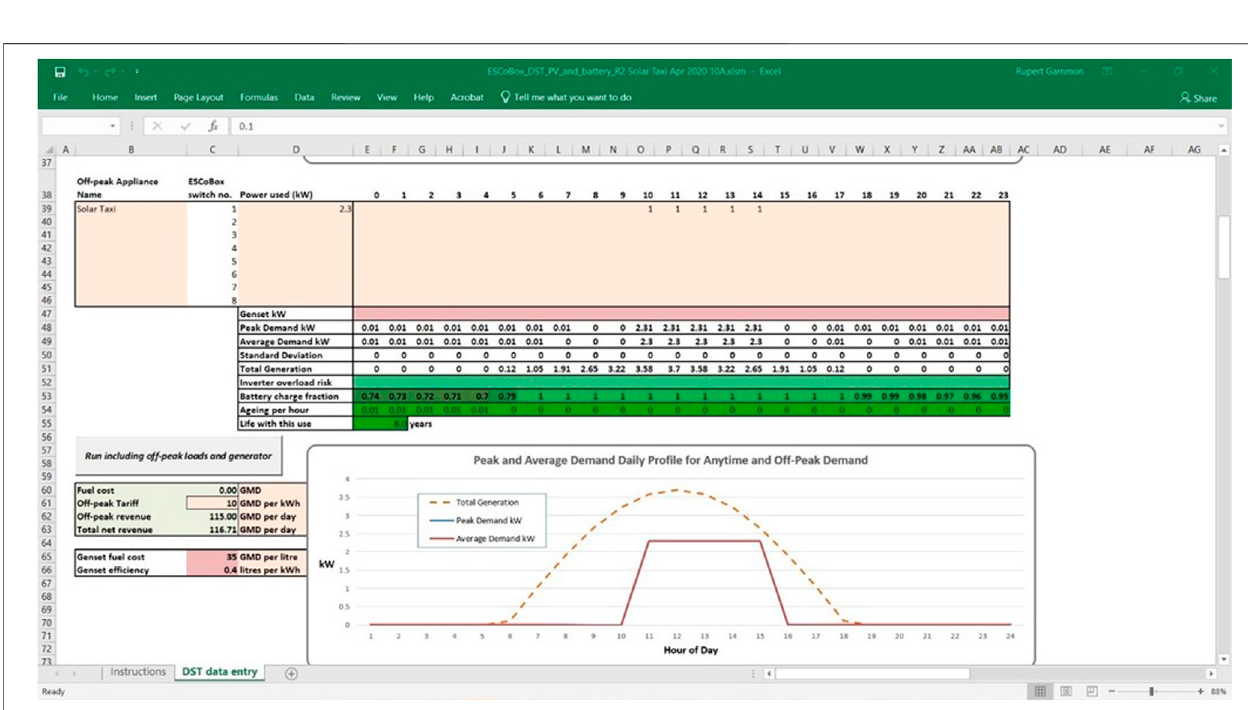
Frontiers in Energy Research |